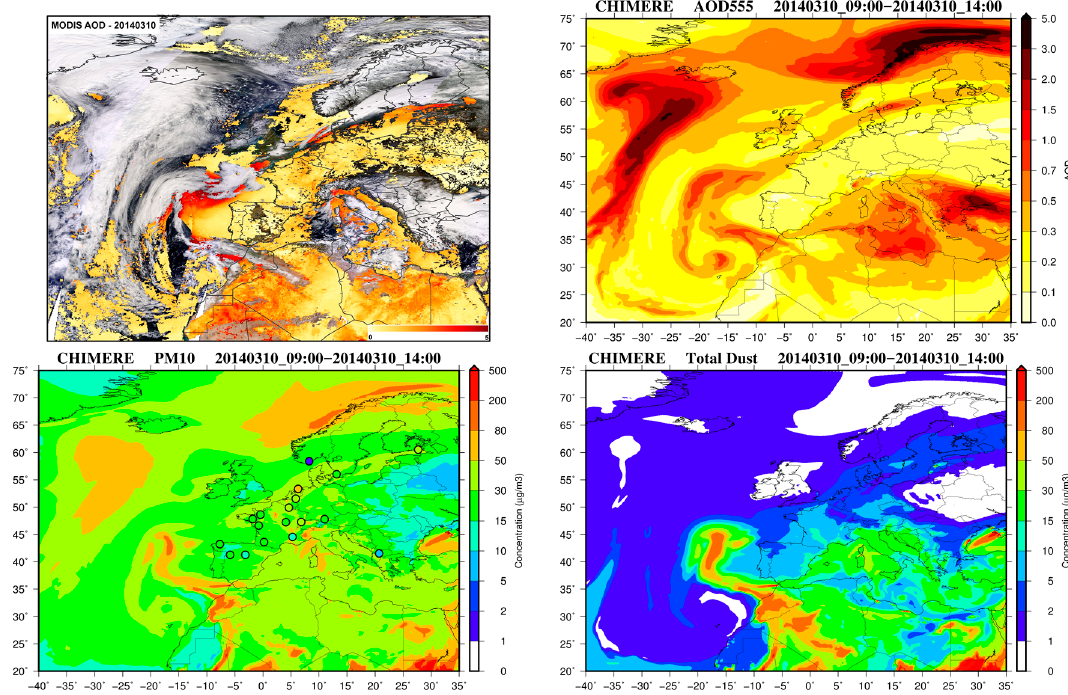
Figure 14. Top panels represent the AOD 555 nm retrieved by MODIS on 10 March as a composite of several orbits from 09:00 to 14:00 UTC ( left ), CHIMERE AOD 555 nm for the time range ( right ). Bottom panels represent the ground concentrations of total dust ( right ) and PM 10 ( left ) with observations represented by circles.